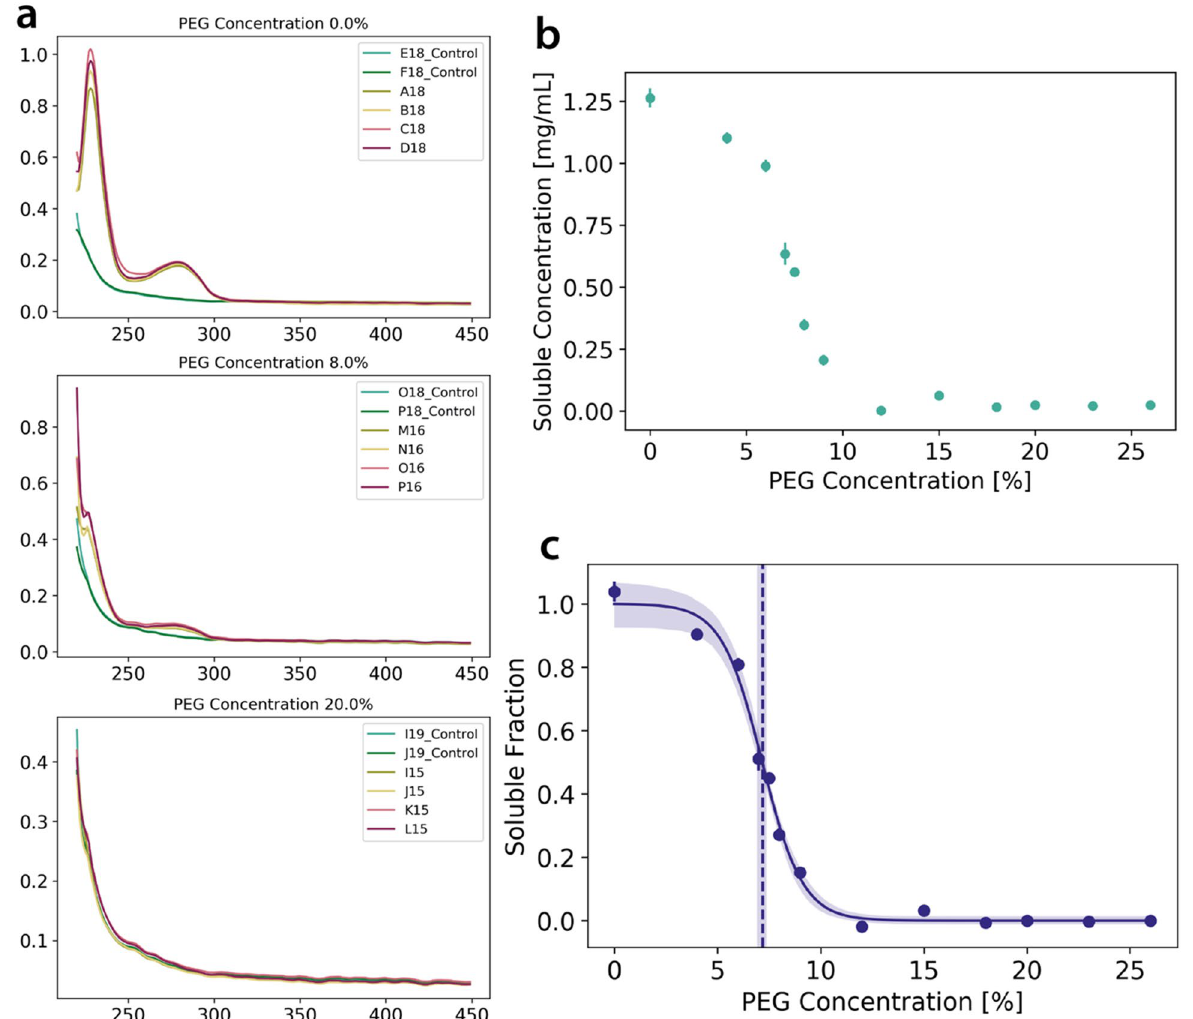
Figure 3. Step-by-step data acquisition and fitting. (a) In a pre-analysis step, possible outliers in the measurements are identified from the raw data, as described in the Data Analysis section. The absorbance profiles are then analysed with their suitable blanks to obtain the protein concentration in the supernatant. ( b) For each PEG concentration, the soluble concentration of the protein is calculated from the absorbance at 280 nm and plotted. ( c) Following a normalisation step, a sigmoid function is fitted through the soluble fraction to acquire the PEG 1/2 value as a proxy for relative solubility. A 95% confidence interval analysis is carried out here to estimate the error on the PEG 1/2 and the quality of the